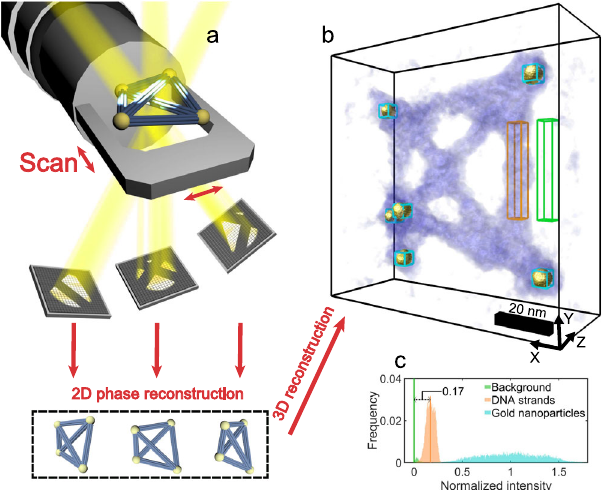
Fig. 1 | Schematic experimental setup and reconstruction of electron ptycho- graphic tomography. a Schematic diagram of the experimental setup. b 3D ren- dering of the phase-contrast of a DNA origami framework reconstructed from a ptychographic tomographic dataset. c Frequency histogram of the background (green), DNA strands (orange) and gold nanoparticles (light blue) indicated by coloured boxes in ( b